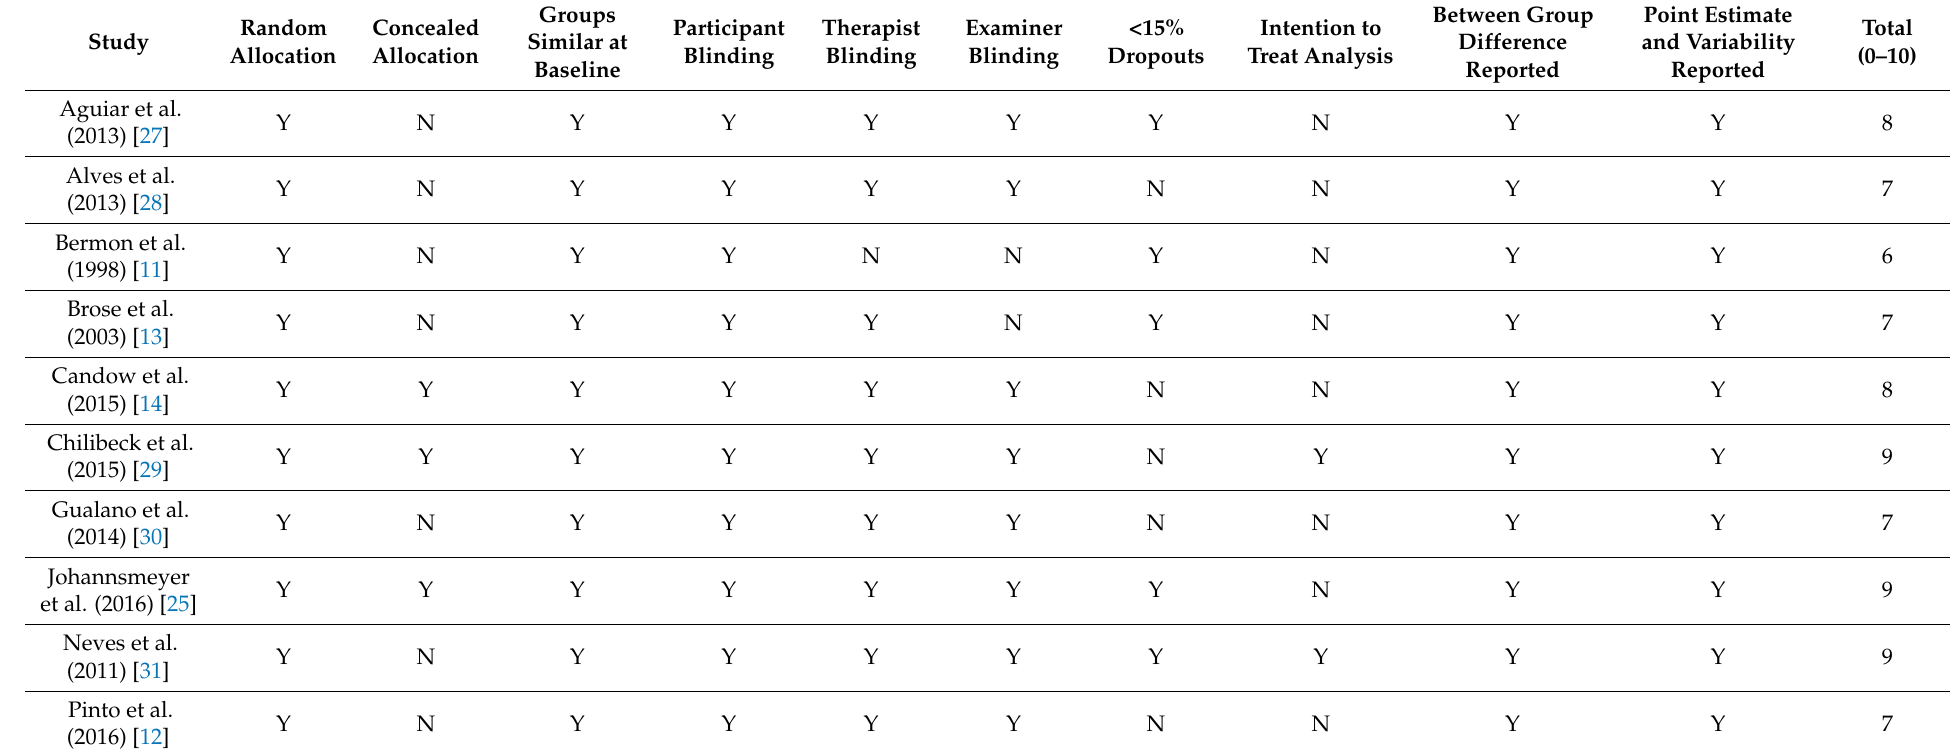
Table 2. PEDro score ( n =